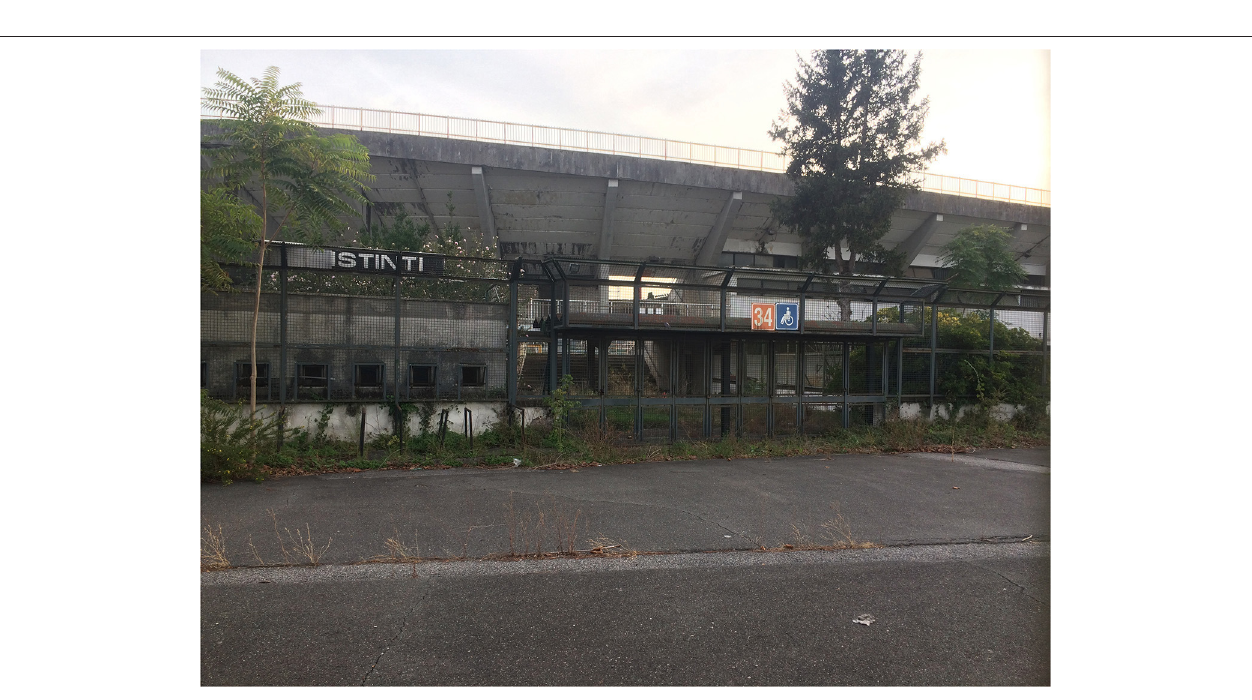
addition to on-site guidance, Romeo lectured on the restoration project on two separate occasions at the Norwegian Institute in